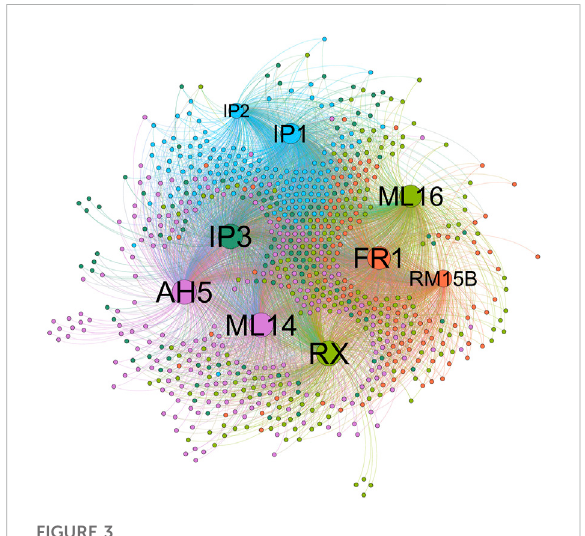
FIGURE 3 Correlation coexpression network graph (Use Gephi software ’ s Force Atlas layout to map the network).